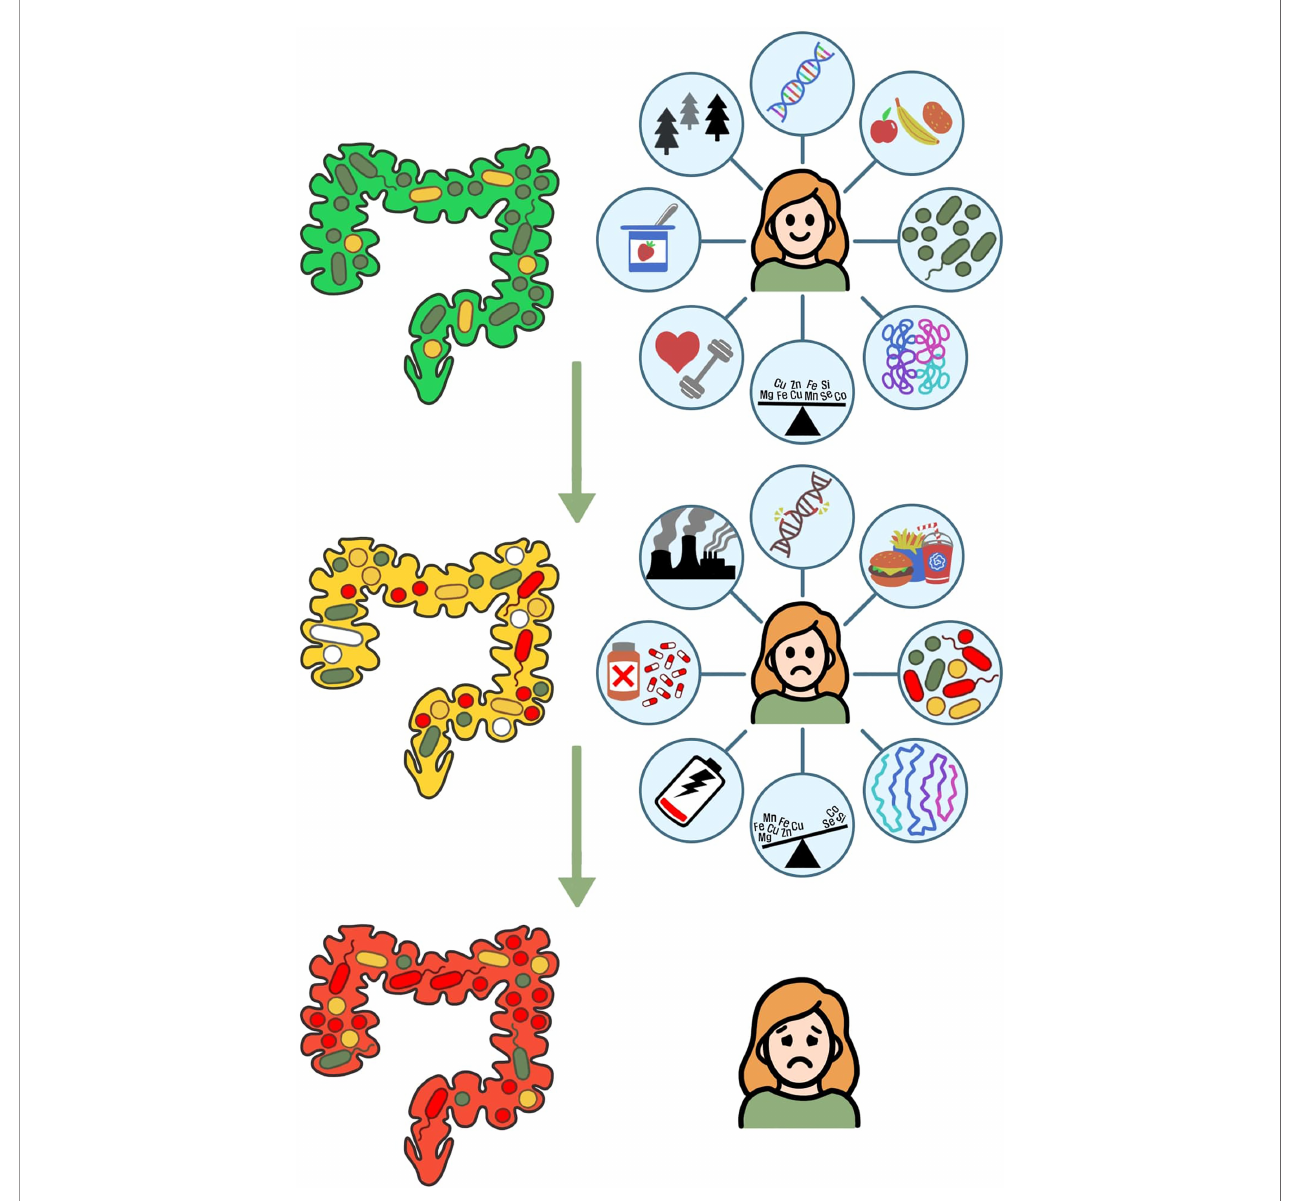
FIGURE 1 | A healthy host and associated commensal microbiota enforces an environment that prevents colonization by invasive pathogens. However dysregulation of host physiology and native microbial communities is in fl uenced by environmental factors. Through adverse community stressors such as DNA or protein impairment, poor diet, depleted microbial diversity, excessive metals, an inactive lifestyle, antibiotic usage, and adverse environment. The two-pronged attack of dysregulation of both microbial communities and host homeostasis leads to dysbiosis of bene fi cial bacteria, thus facilitating disease outcomes of individuals and formation of new microbial communities re fl ective of the